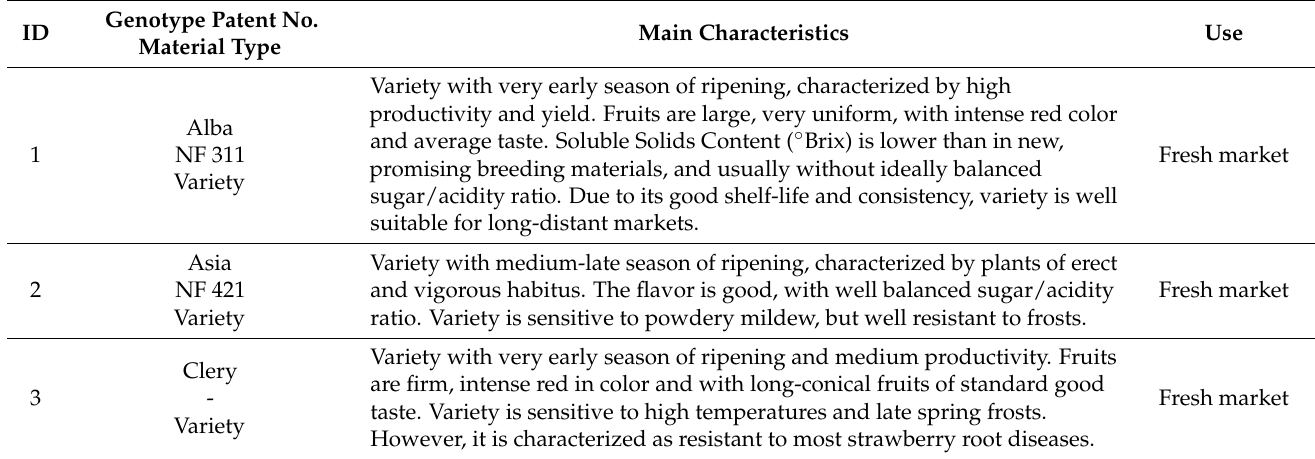
Table 2. Main characteristics of six genotypes of investigated